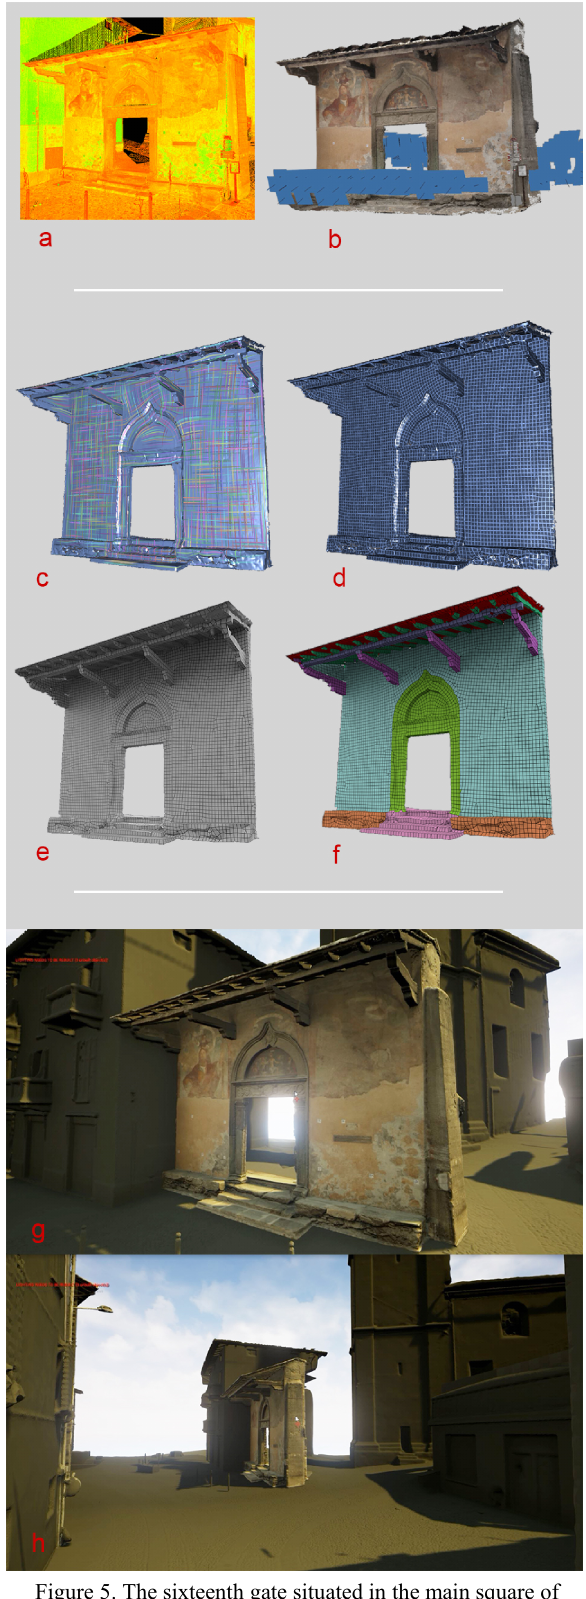
Figure 5. The sixteenth gate situated in the main square of Chiuro: (a) Point cloud; (b) Photogrammetric model; (c-d) Remeshing procedure in InstantMeshes (GitHub); (e) Quad- dominant isotropic mesh; (f) Semantic partition; (g-h) Frames derived from a walkthrough in the game-engine